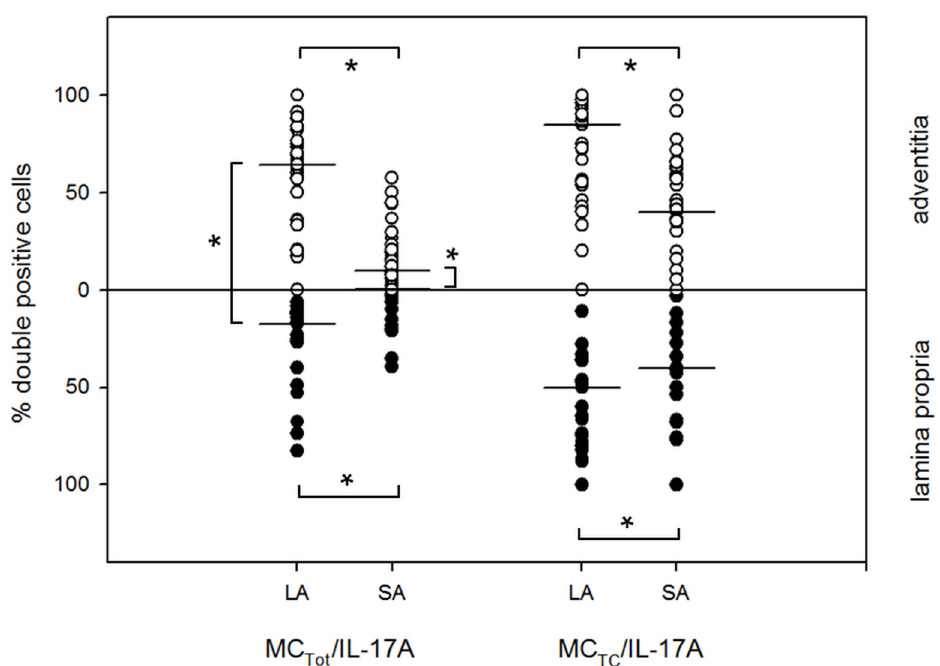
Fig 3. Percentage of IL-17A positive mast cells. Median percentage of IL-17A positive mast cells in the lamina propria and adventitia of large (LA) and small airways (SA) is presented. * P < 0.05.